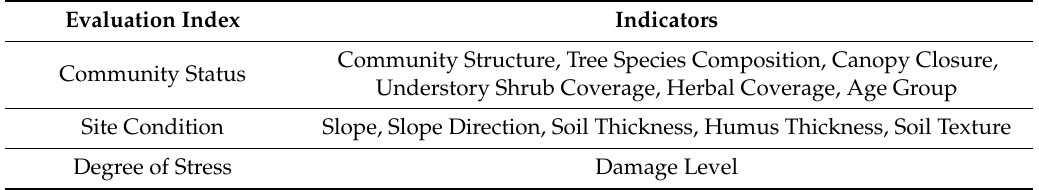
Table 1. Index system for the Mount Taishan forest ecosystem health